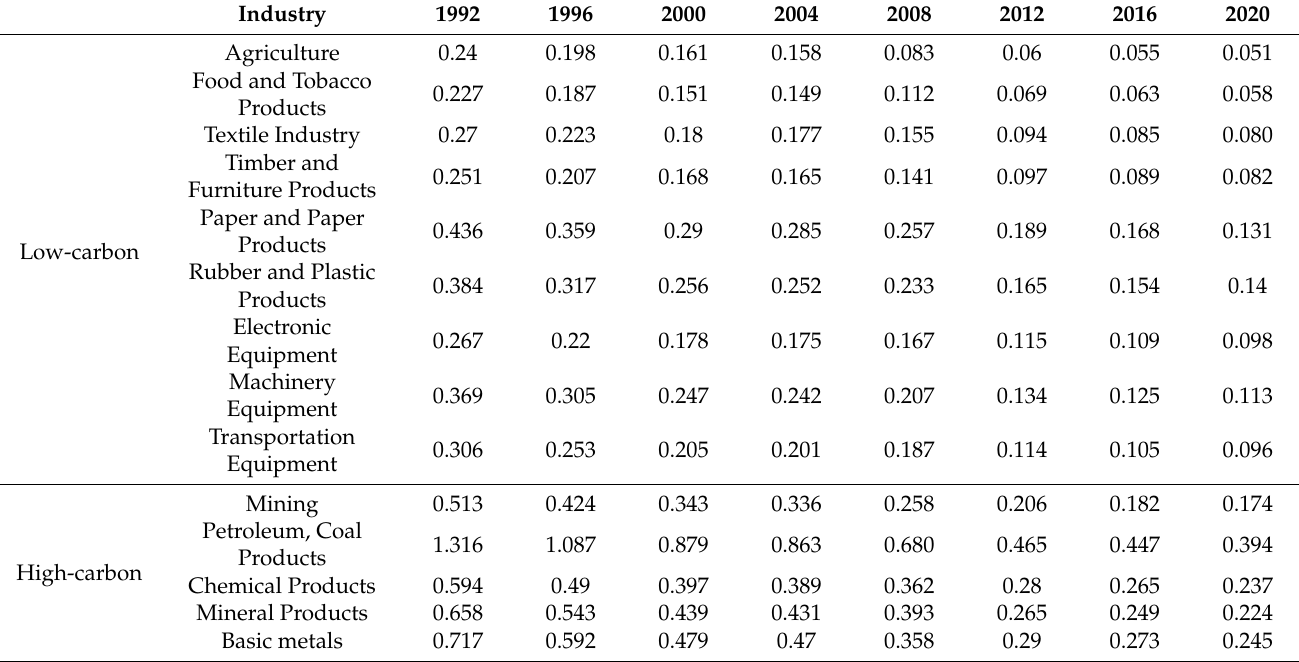
Table A1. The embodied carbon emission intensity by industry from 1992 to 2020.